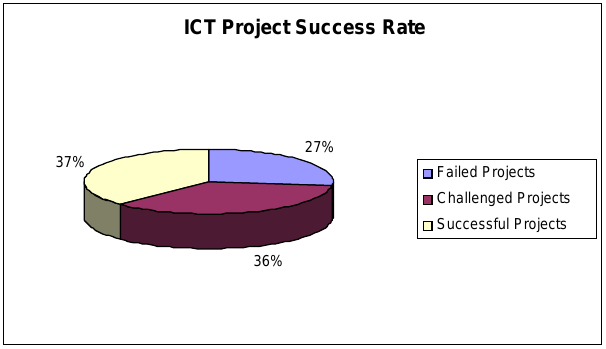
Figure 1: ICT Project Success Rate